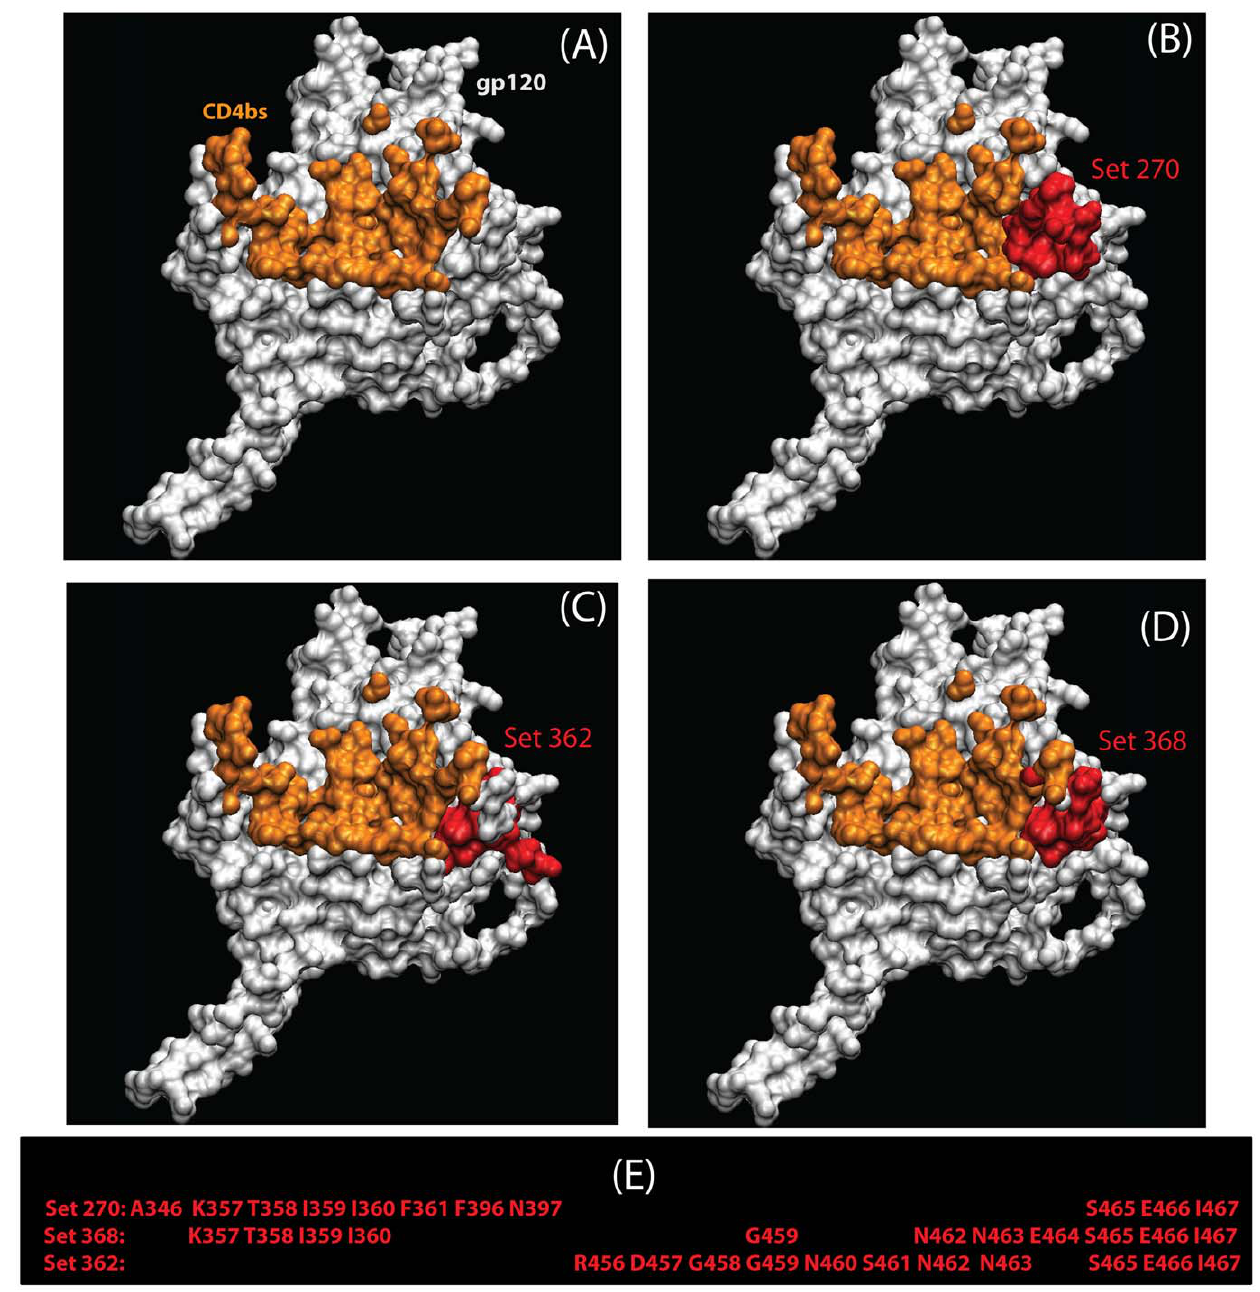
Figure 3. Three statistically significant structures-based regional clusters in gp120 (white) associated with changes in polarity. These regional clusters occur near the CD4-binding site (orange) shown in ( A ). The CD4-bound conformation of the HIV-1 gp120 core + V3 is shown, from the perspective seen by CD4. The three clusters ( B–D ) are shown in red. The residues that form these sets are shown in panel ( E ). All maps are based on HXB2